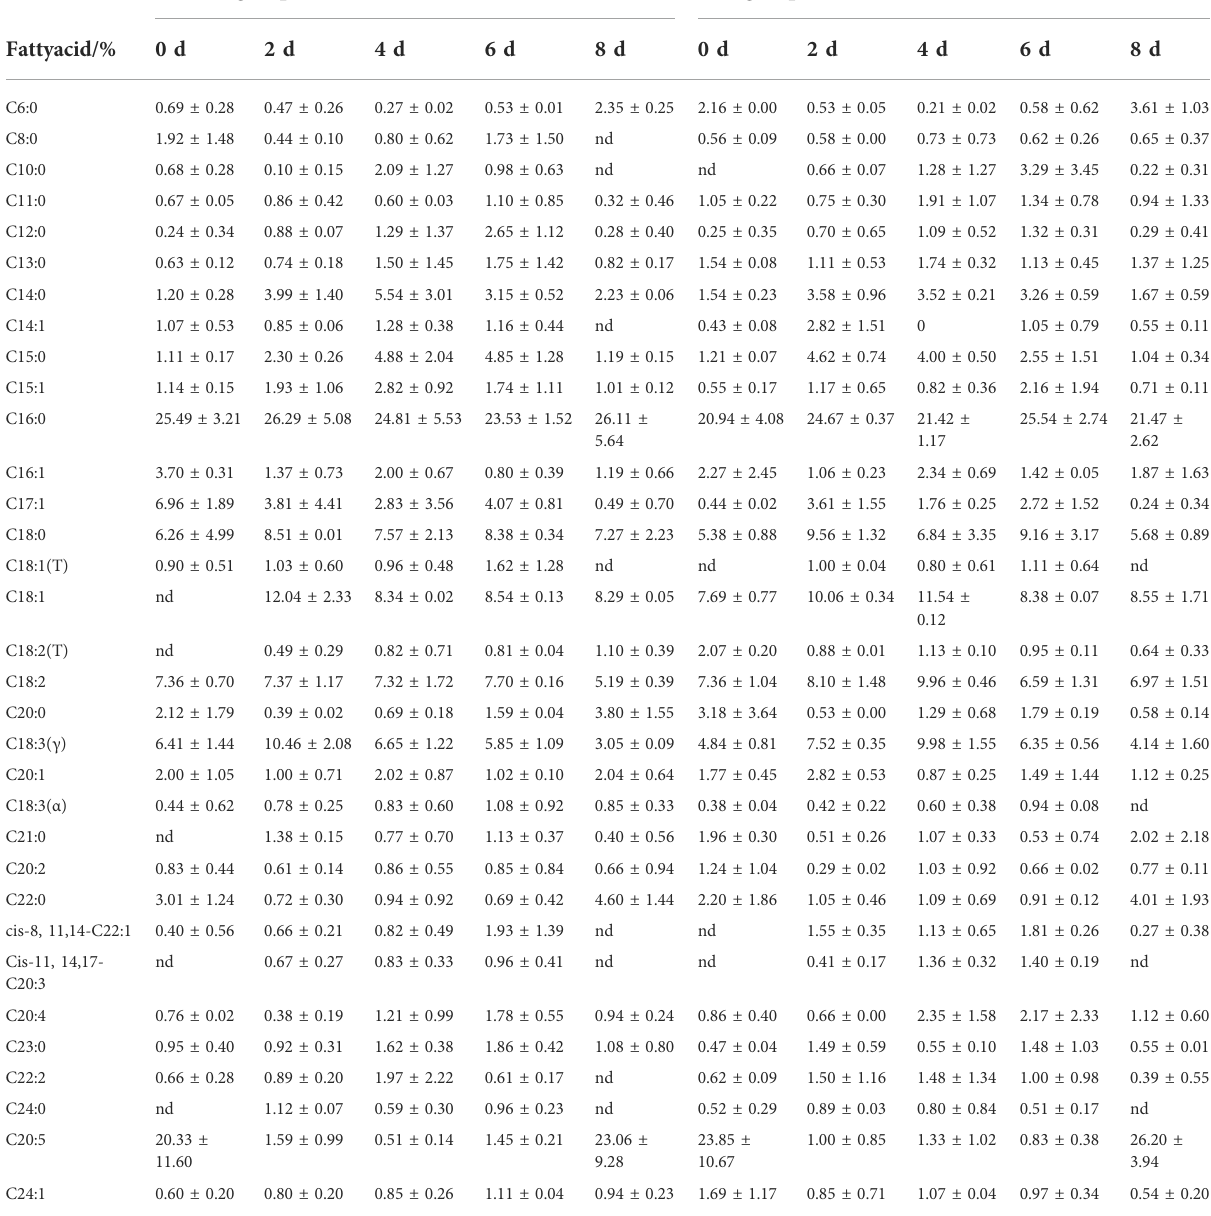
TABLE 4 Fatty acid composition of cigar tobacco leaves after